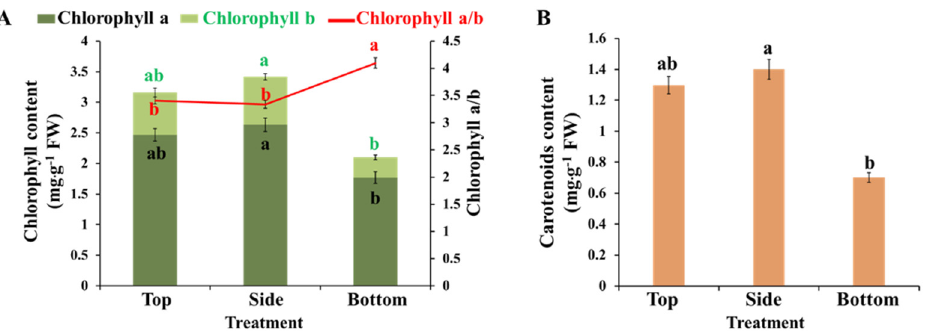
Figure 6. Changes in the photosynthetic pigment contents in strawberry ‘Sulhyang’ as affected by the lighting direction after 45 days of cultivation. Chlorophyll contents and chlorophyll a to b ratio ( A ), carotenoids contents ( B ). Vertical bars indicate the means ± standard error ( n = 6). Different lowercase letters indicate significant separations within treatments by Duncan’s multiple range test at p ≤ 0.05.